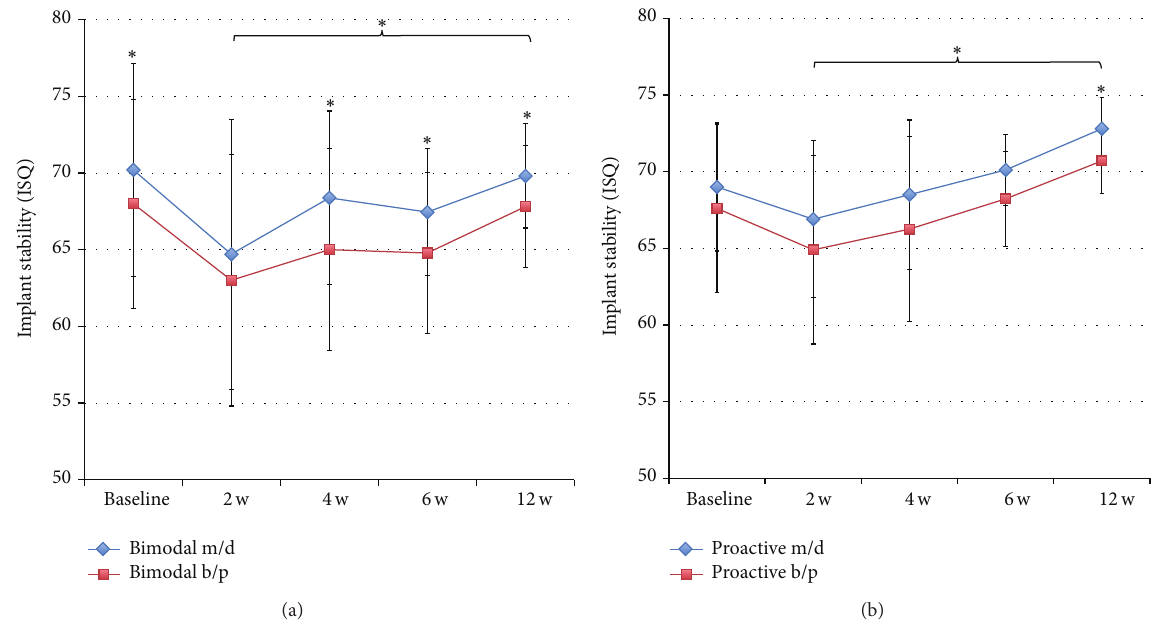
Figure 5: (a) Showing differences between RFA measurements in MD and BP directions for bimodal implants. ∗ 𝑝 ≤ 0.05 . (b) Showing differences between RFA measurements in MD and BP directions for proactive implants. ∗ 𝑝 ≤ 0.05 .